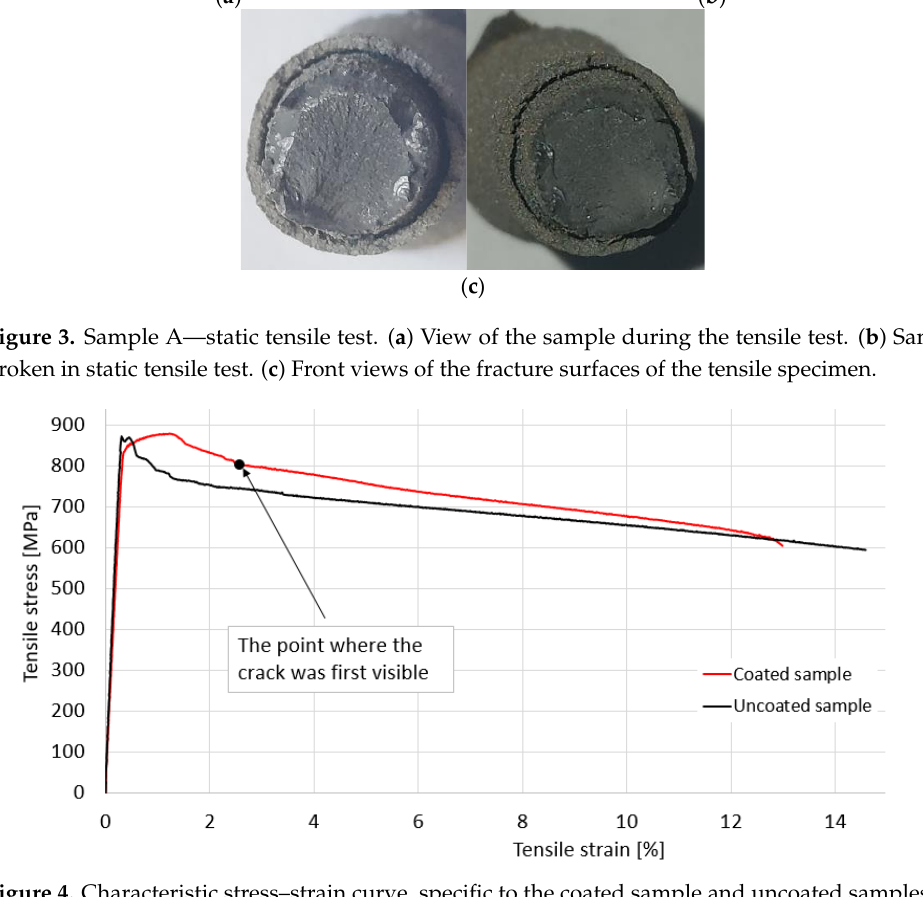
Figure 4. Characteristic stress – strain curve, specific to the coated sample and uncoated samples.